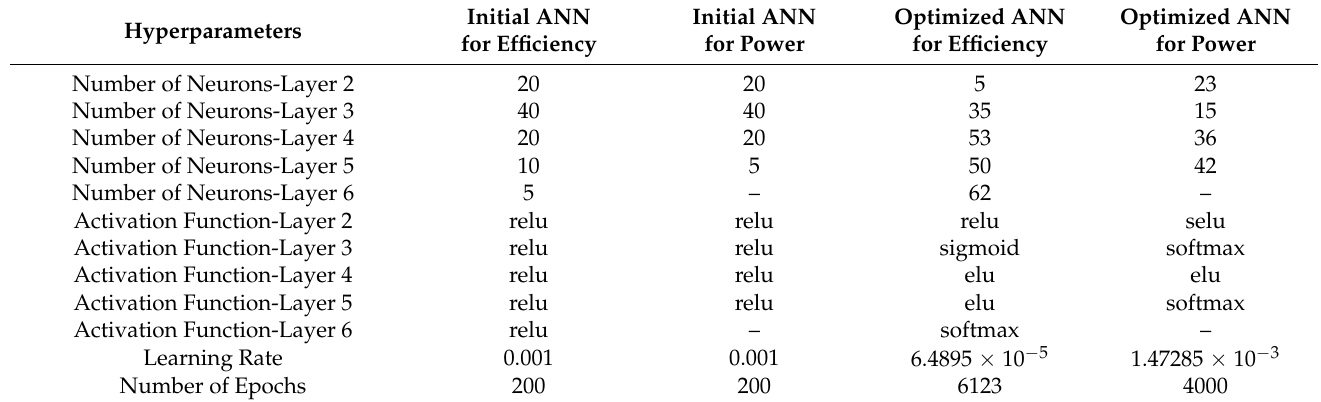
Table 1. Hyperparameters of the initial and optimized ANN